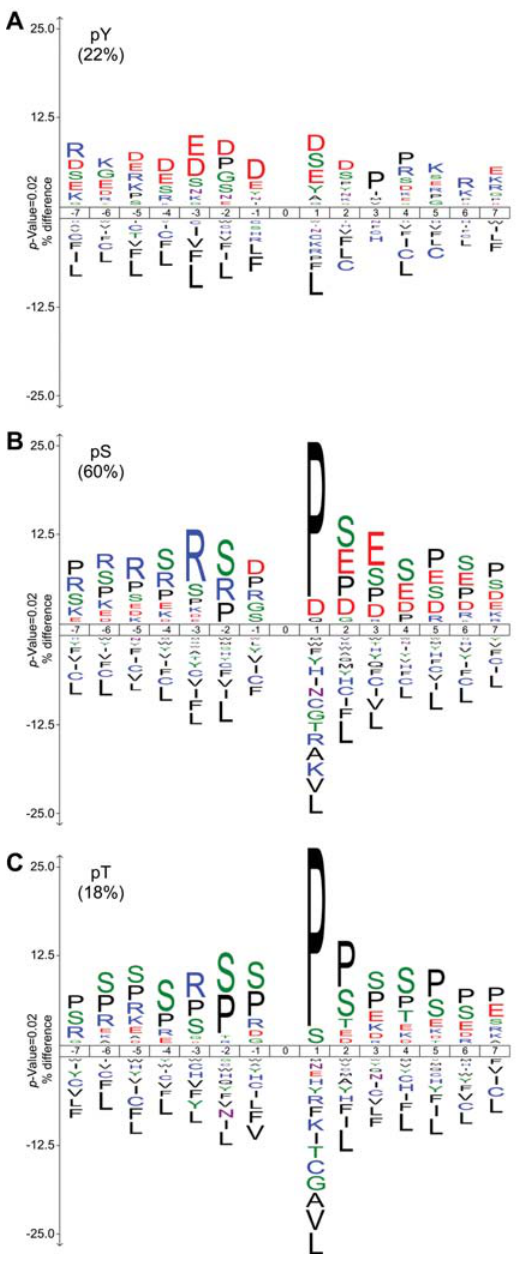
Figure 5 IceLogo analysis of pY, pS, pT sites vs. random. IceLogo representation highlighting the different residue distribution surrounding pY, (A) pS (B) and pT (C) residues regarding the ran- dom distribution. Random and phosphopeptides are collected as described in the Methods